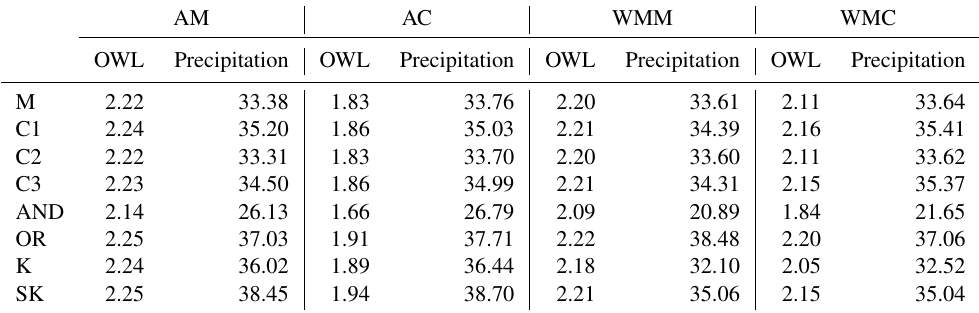
Table 7. San Diego 10-year marginal (M), conditional (C), and bivariate OWL (m) and precipitation (mmd − 1 ) values using the BB1 with annual maximum (AM), annual coinciding (AC), wet-season monthly maximum (WMM), and wet-season monthly coinciding (WMC) samplings. Conditionals are conditioned on a 25-year event